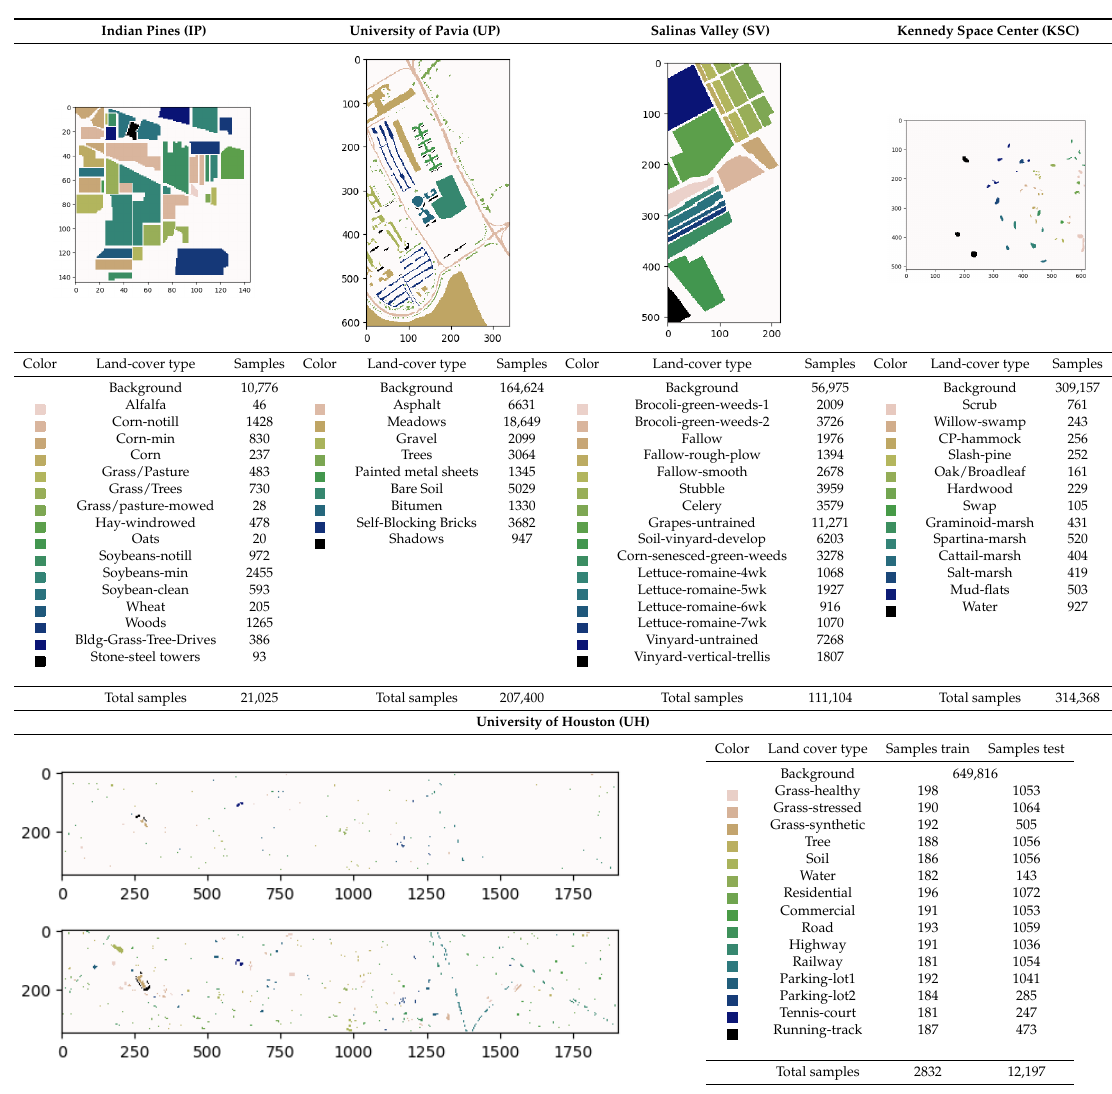
Table 2. Number of samples of the Indian Pines (IP), University of Pavia (UP), Salinas Valley (SV), Kennedy Space Center (KSC) and University of Houston (UH) hyperspectral data